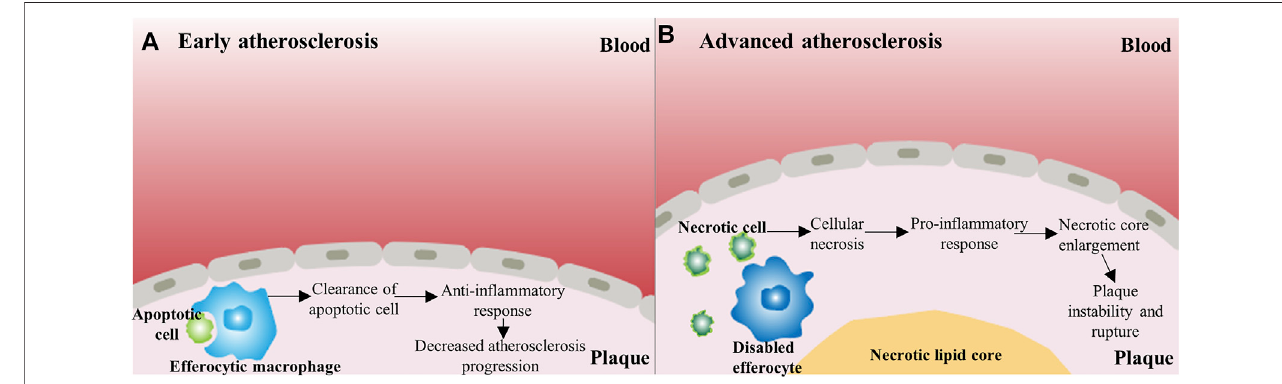
FIGURE 1 | The dual role of macrophage apoptosis in early and advanced atherosclerosis (A) In early atherosclerosis, efferocytosis is ef fi cient, and apoptotic cells are rapidly cleared by efferocytes, which can trigger a positive anti-in fl ammatory response, then resulting in decreased atherosclerosis progression (B) In advanced atherosclerosis, disabled efferocytes cannot function properly. Subsequently, the accumulation of apoptotic cells results in secondary necrosis and an in fl ammatory response ensues. These phenomena may further increase the risk of plaque rupture.